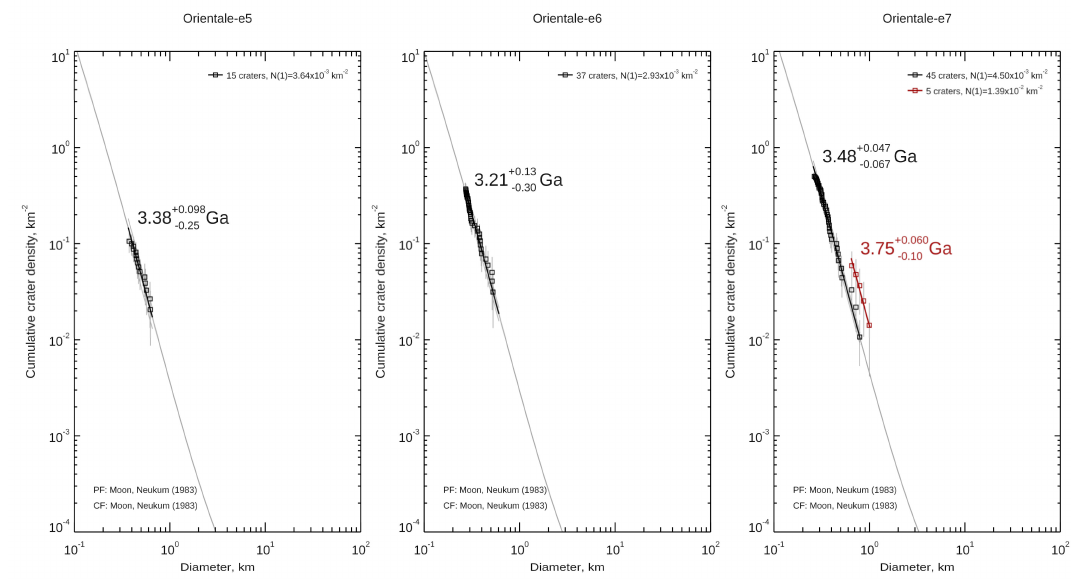
Figure 7. CSFD and mean AMAs of sub-units e5–e7 in Lacus Autumni. Black characters denote the surface age of basalts, the red and green represent the older age of the underlying basalt. The AMAs were estimated with the Craterstats2 Tool with the production and chronology functions of